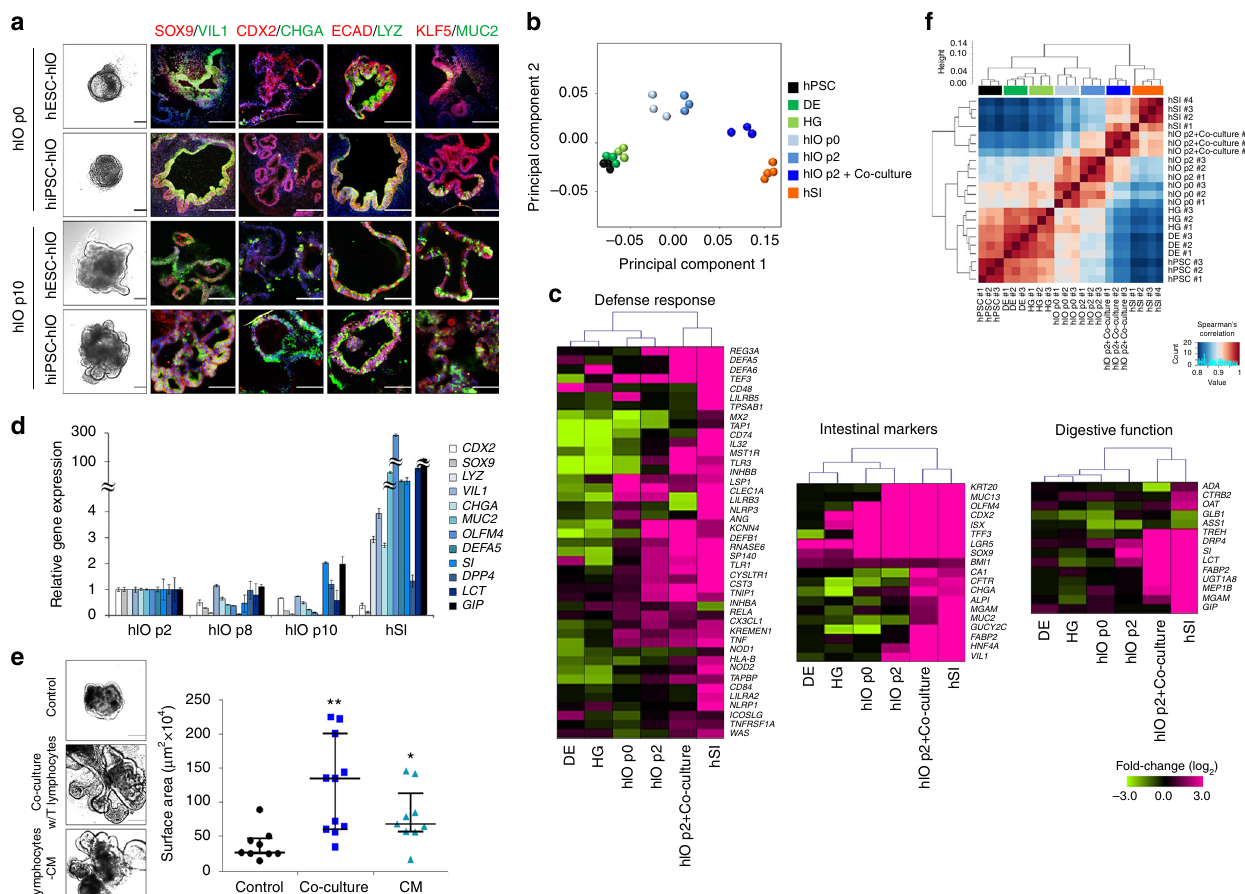
Fig. 1 hPSC-derived hIOs undergo maturation during co-culture with immune cells. a Representative morphology and immuno fl uorescent staining of hIOs (p0, p10) for gut-speci fi c markers (SOX9, CDX2, and KLF5); the enterocyte marker, VIL1; the goblet cell marker, MUC2; the Paneth cell marker, LYZ; the enteroendocrine cell marker, CHGA; and the epithelial marker, ECAD. Scale bar, 200 μ m. b Principal component analysis (PCA) of differentially expressed genes (>2-fold change) from microarray experiments comparing de fi nitive endoderm cells (DE) ( n = 3), hindgut cells (HG) ( n = 3), hIOs (p0) ( n = 3), hIOs (p2) ( n = 3), co-cultured hIOs ( n = 3) and adult human small intestine (hSI) ( n = 4). c Heatmaps of genes involved in the defense response, intestinal markers and genes required for digestion, demonstrating that co-cultured hIOs are the cell type most similar to adult hSI. d qPCR analysis of the expression of intestinal markers and maturation markers in hIO (p2, p8, p10) and hSI. e Representative images of morphological changes occurring in hIOs following co-culture with PMA/ionophore-stimulated Jurkat T cells or treatment with stimulated Jurkat T cell-conditioned medium (CM). Scale bar, 1 mm. Quantitative assessment of the size of hIOs after two passages; n = 9 (control), n = 11 (co-culture), n = 9 (CM) hIOs per group. PMA phorbol myristate acetate, CI calcium ionophore. f Spearman ’ s correlation was used to cluster samples and generate a heatmap. Red indicating the highest level of similarity between samples and blue indicates the lowest level of similarity. The dendrogram indicates that co-cultured hIOs are similar to hSI samples. Data are presented as mean values of replicates ± SEM. ** p < 0.01, * p < 0.05, according to t